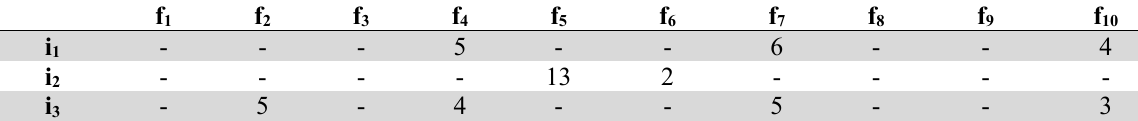
Raw material distribution (in full-truckloads)